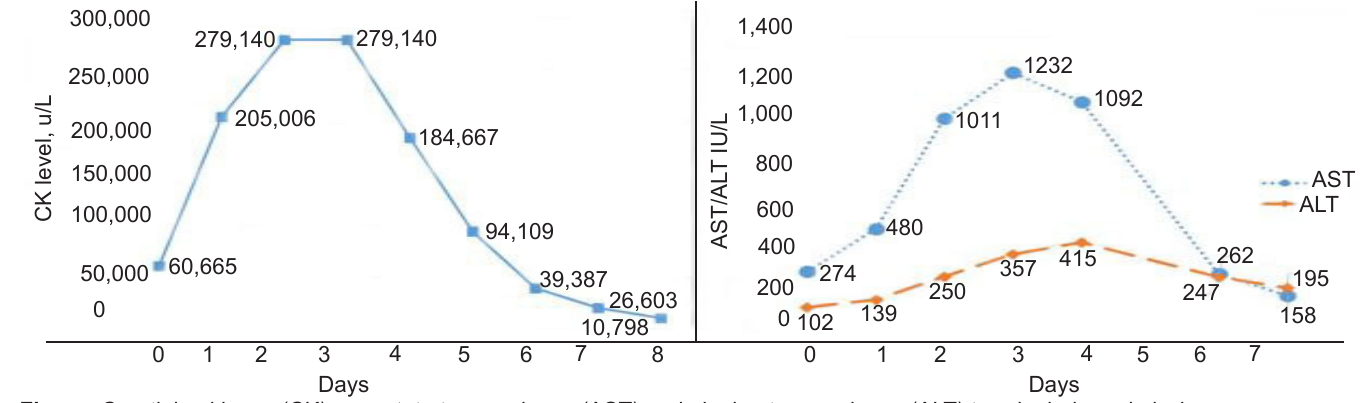
Figure. Creatinine kinase (CK), aspartate transaminase (AST) and alanine transaminase (ALT) trends